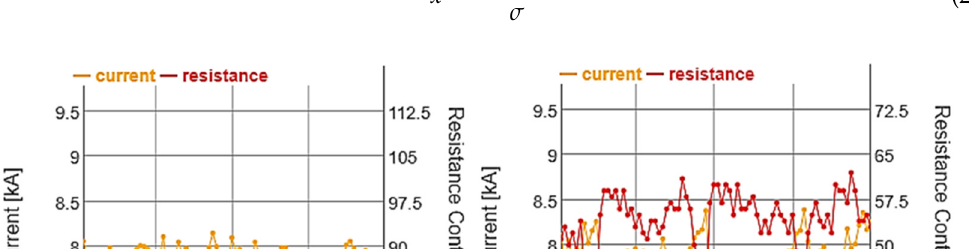
acquired for a welding gun with correct milling; ( b ) Example of the data